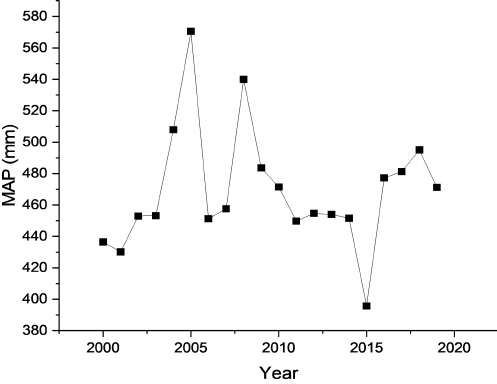
Figure A4. Mean annual precipitation (MAP) on the QTP from 2000–2019.